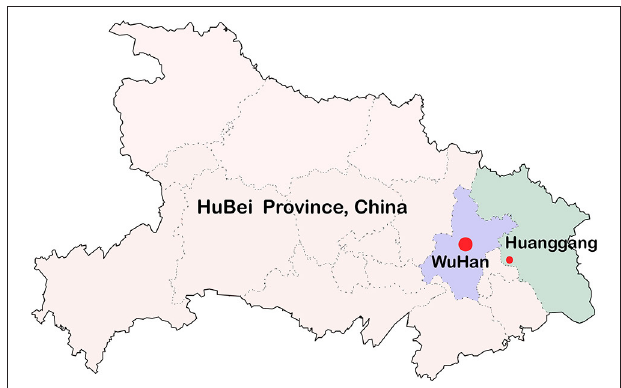
FIGURE 1 | Geographical location of Huanggang, where the respondents were